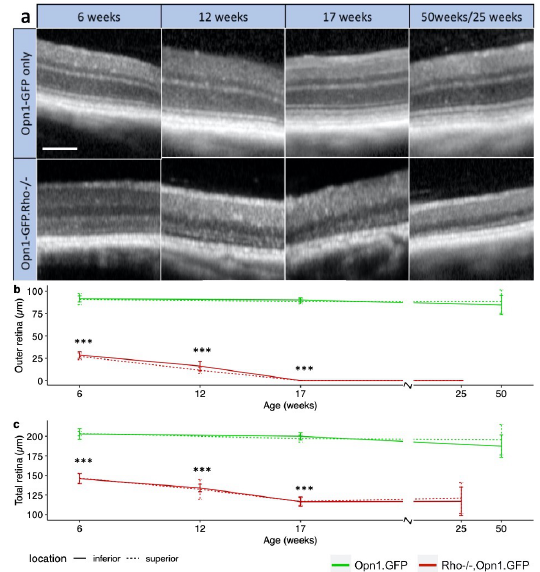
Figure 2. Changes in retinal structural in Rho − / − OPN1-GFP mice. ( a ) Representative OCT images for Rho −/− OPN1-GFP mice and OPN1-GFP controls at each time point, showing the loss of outer retina. White scale bar = 100µm. ( b ) Degeneration of the outer retinal thickness and ( c ) total retinal thickness measured on OCT for Rho −/− OPN1-GFP mice (red) occurs rapidly and differs from non-degenerate OPN1-GFP mice (green) as early as PNW6. Total retinal thickness was measured from the inner margin of the nerve fiber layer to the inner margin of the RPE. Outer retinal thickness was measured from the inner margin of the outer nuclear layer to the inner margin of the RPE. *** denotes p < 0.001; values are mean ± SEM. Tissue collected from Rho −/− OPN1-GFP PNW 6 (n = 7 mice), PNW 12 ( n = 3), PNW 17 ( n = 8), and PNW 25 ( n = 3) and in wild-type OPN1-GFP mice at PNW 6 ( n = 4), PNW 17 ( n = 6) and PNW 50 ( n = 2).